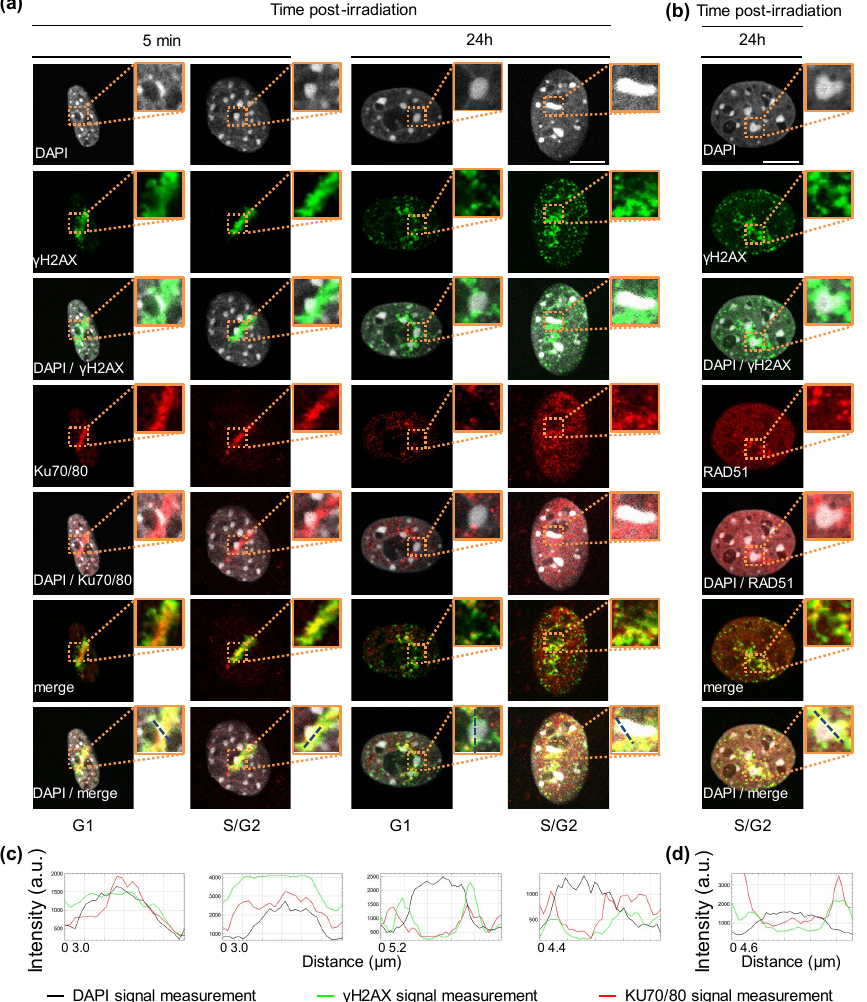
Figure 5. Recruitment of the KU complex and RAD51 at the chromocenters of NIH-3T3 cells irradiated with α -particles. ( a , b ) Localization of the KU70/80 dimer and RAD51 protein relative to chromocenters 5 min and 24 h post-irradiation. For the indicated time after localized α -particle irradiation, we re-analyzed irradiated NIH-3T3 cells, which were part of the data of Figure 4, and which were immunostained with antibodies against γ H2AX and KU70/KU80 ( a ) or RAD51 ( b ). Enlarged views of the dotted orange boxed regions are shown (bold boxes). DNA was stained with DAPI. Bars represent 10 µ m. ( c , d ) The intensity profiles displayed correspond to the dashed blue lines in each enlarged merge view that go through a chromocenter. They show the intensity measurements in arbitrary units (a.u.) from the staining of DAPI, γ H2AX and either KU70/80 ( c ) or RAD51 ( d